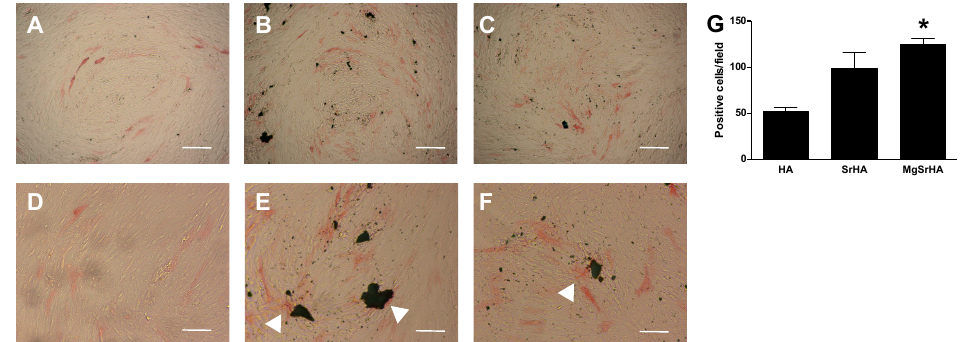
Figure 5. ( A – F ): Alkaline phosphatase (ALP) staining: microphotographs of primary human osteoblasts cultured in the presence of complete DMEM enriched with 0.3 mg/mL ( A , D ) hydroxyapatite (HA), ( B , E ) Sr-substituted HA (SrHA) and ( C , F ) magnesium, strontium-substituted HA (MgSrHA) and stained for ALP (red staining). White arrowheads indicate ALP-positive cells in proximity of material granules. Cells were observed at phase contrast. Magnification: 4 X ( A – C ), bar = 50 μ m or 10 X ( D – F ), bar = 20 μ m. ( G ) Stained cells were counted and plotted as a bar chart. * = p < 0.05 vs. HA.